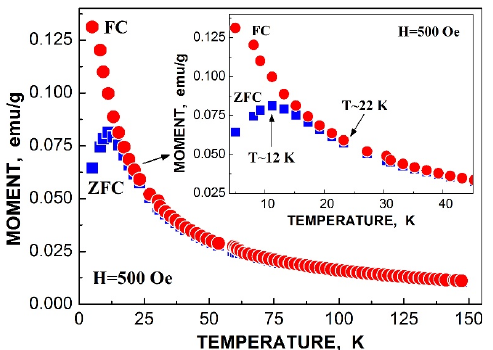
Figure 9. Zero ‐ field ‐ cooled (ZFC) and field ‐ cooled (FC) curves for human liver ferritin iron cores. Adapted from Ref. [51] with permission from Elsevier: Journal of Inorganic Biochemistry, Vol. 213,